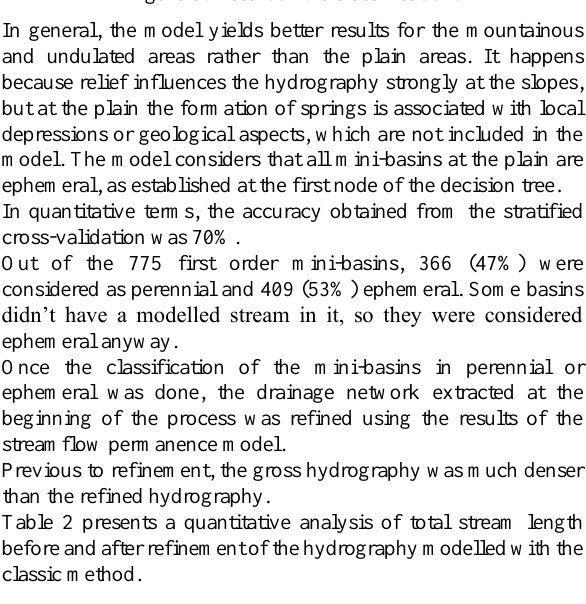
Figure 5: Result of the classification.